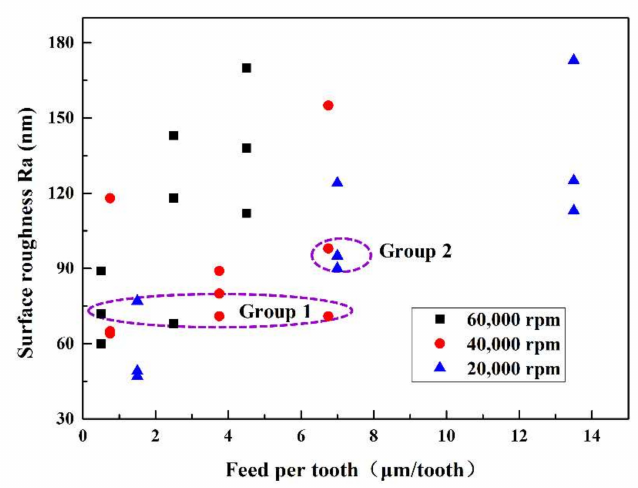
Figure 4. Grove bottom surface morphology with di ff erent processing parameters. (The results were measured by the laser scan confocal microscope (VK-X250, Keyence Co., Osaka, Japan) with a 20 × microscope lens).